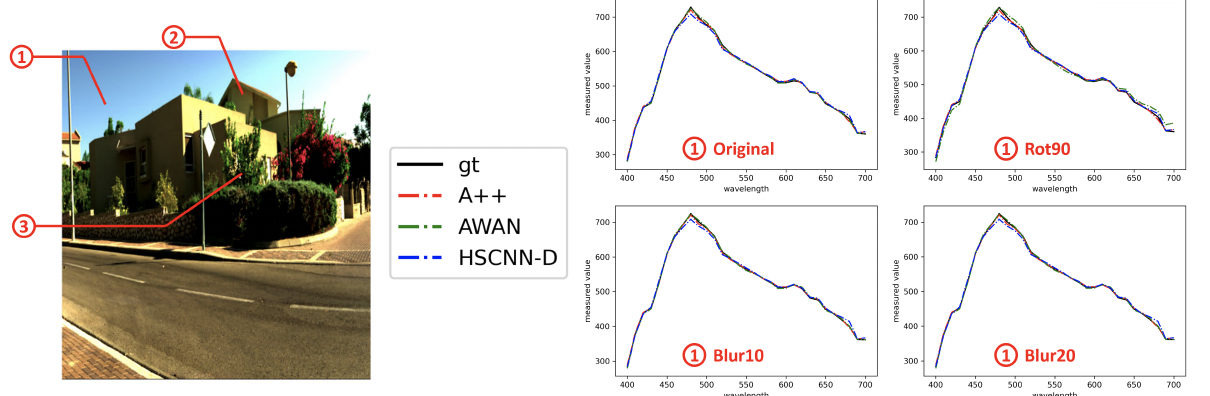
Figure 5. Visualization of selected ground-truth and recovered spectra (continued in Figure 6). Left: 3 pixels specified in an example scene. Middle: Legend for the spectral plots—in all plots in Figures 5 and 6, ground-truth (gt) is shown in black, A++ in red, AWAN in green, and HSCNN-D in blue. Right: The recovery of spectra in the “sky” region (i.e., region 1 (cid:13) in the example scene) under the Original, Rot90, Blur10 and Blur20 imaging